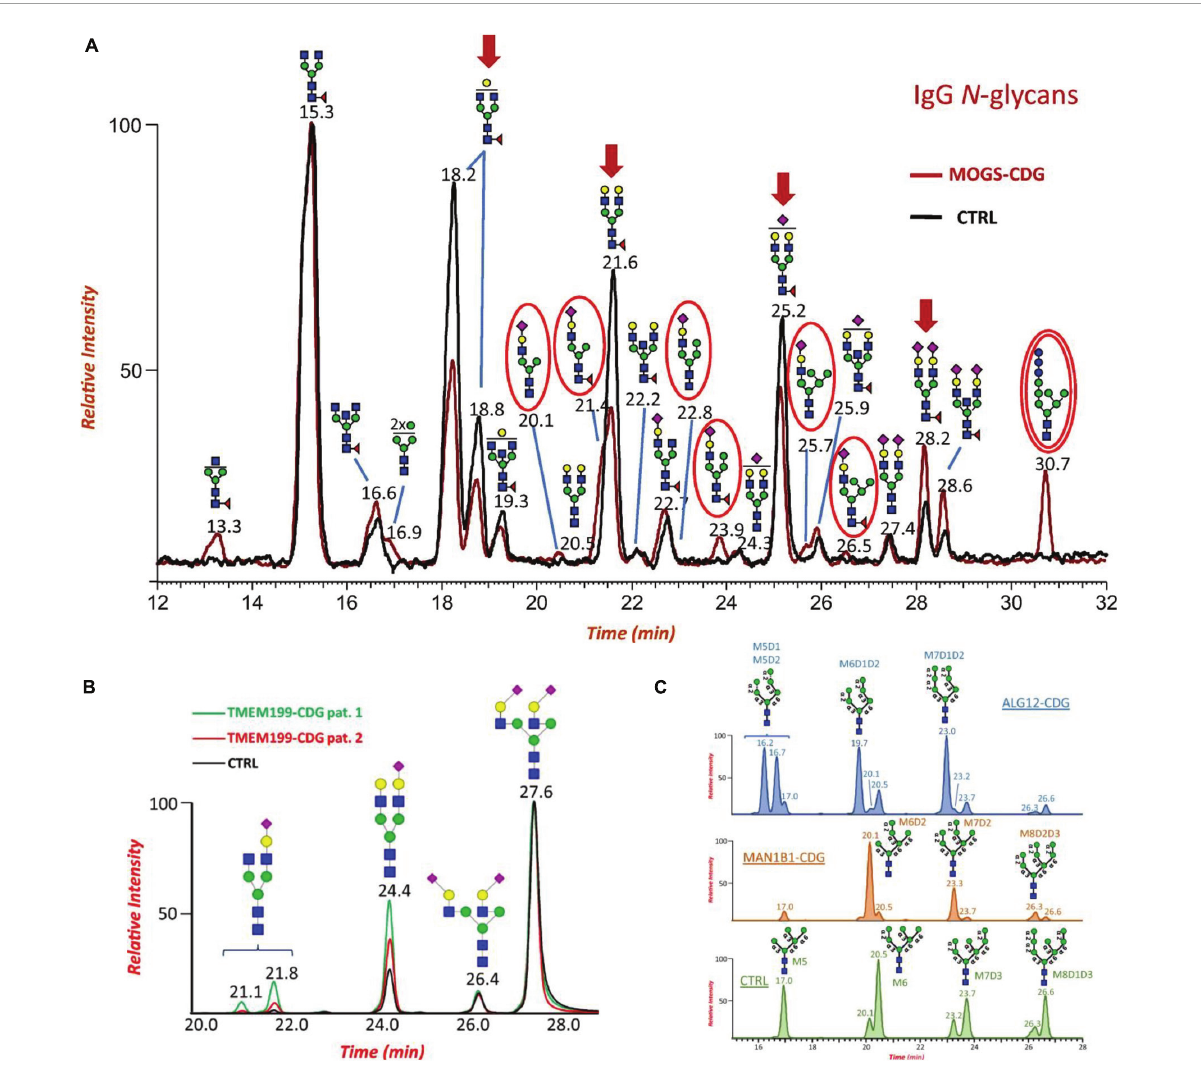
FIGURE2 (A) Overlaid Total Ion Current Chromatograms (TICCs) of RapiFluor-MS labeled IgG N-glycans from a patient with MOGS-CDG (red line) and control (black line). Major changes of specific glycoforms are noted in patient profile by red arrows. The presence of disease-specific oligomannose N-glycan biomarkers (Glc 3 Man 7 GlcNAc 2 ) is highlighted with a double red circle. (B) Extracted ion chromatograms (EICs) of major RapiFluor-MS labeled biantennary and sialylated N-glycans identified in serum of patient 1 with TMEM199-CDG (green line), patient 2